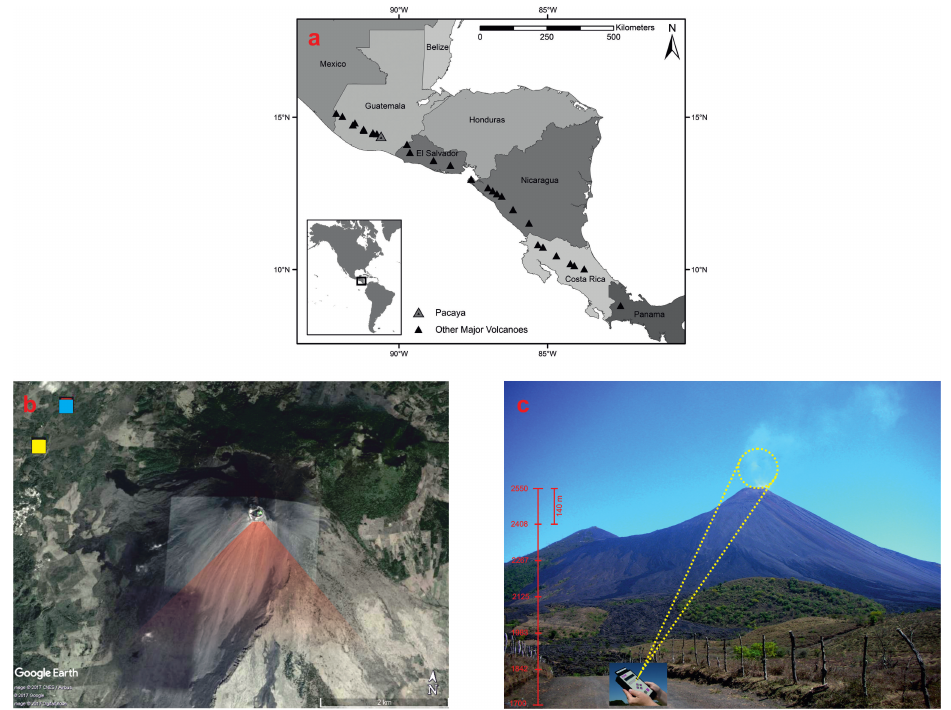
Figure 1. ( a ) Map of the Central American volcanic front [23] showing the location of the volcanoes along the front (black triangles), Pacaya is located in southeastern Guatemala (gray triangle). ( b ) Satellite images of Pacaya showing the direction of plume transport issued by McKenney Cone (reddish area; approximate locations), and the sampling locations from which aerosol optical depth (AOD) measurements were taken on 29 and 30 January 2011 (blue and yellow squares, respectively; Google Earth image CNES 2017). ( c ) View of Pacaya volcano from the western flank of the volcano showing the diluted, roughly vertical plume emitted on 30 January 2011 morning from the volcano summit crater (yellow square in ( b )). The area of the plume captured by the instrument is also displayed, considering the distance of 3500 m between the sampling site and the summit of Pacaya. The calculated radius of the circular observed area is 150 m above the volcano. The dimension of the plume captured in the photo was scaled considering the altitude of the sampling site and that of Pacaya (1700 and 2550 m,